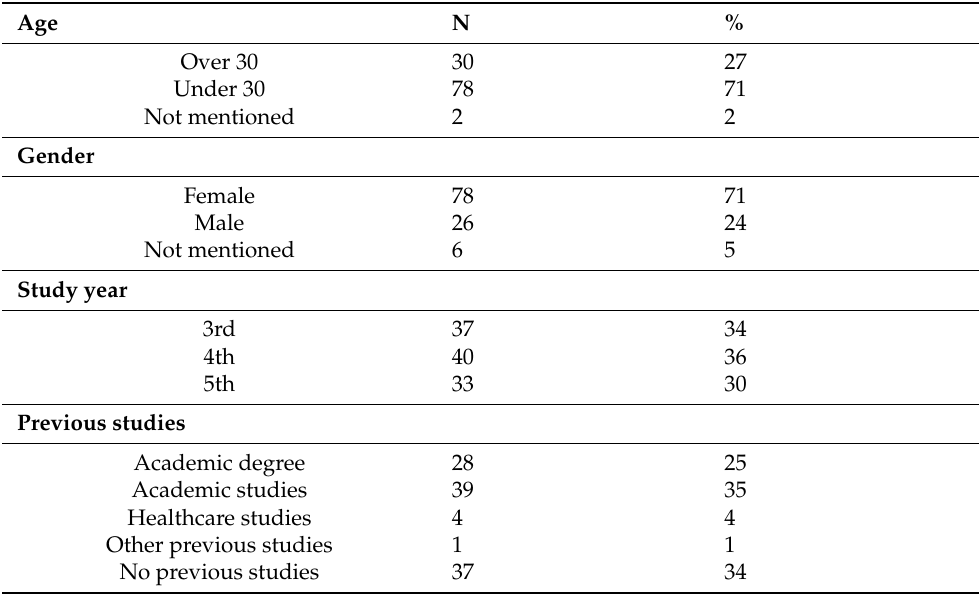
Table 1. Background information on the respondents (n =